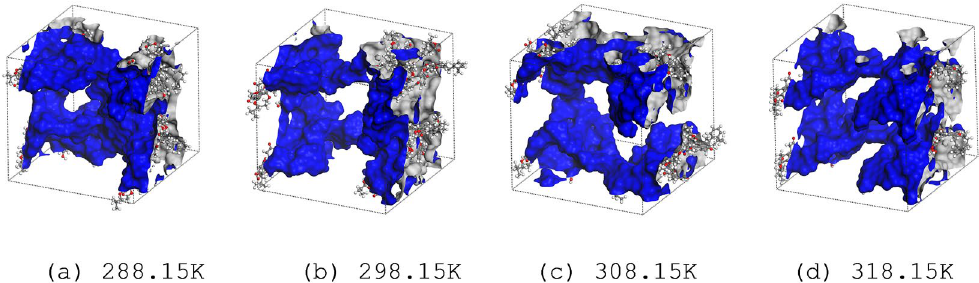
Figure 2. Supercell structures and Connolly surfaces of lignite at different temperatures (Blue areas are Connolly surfaces).